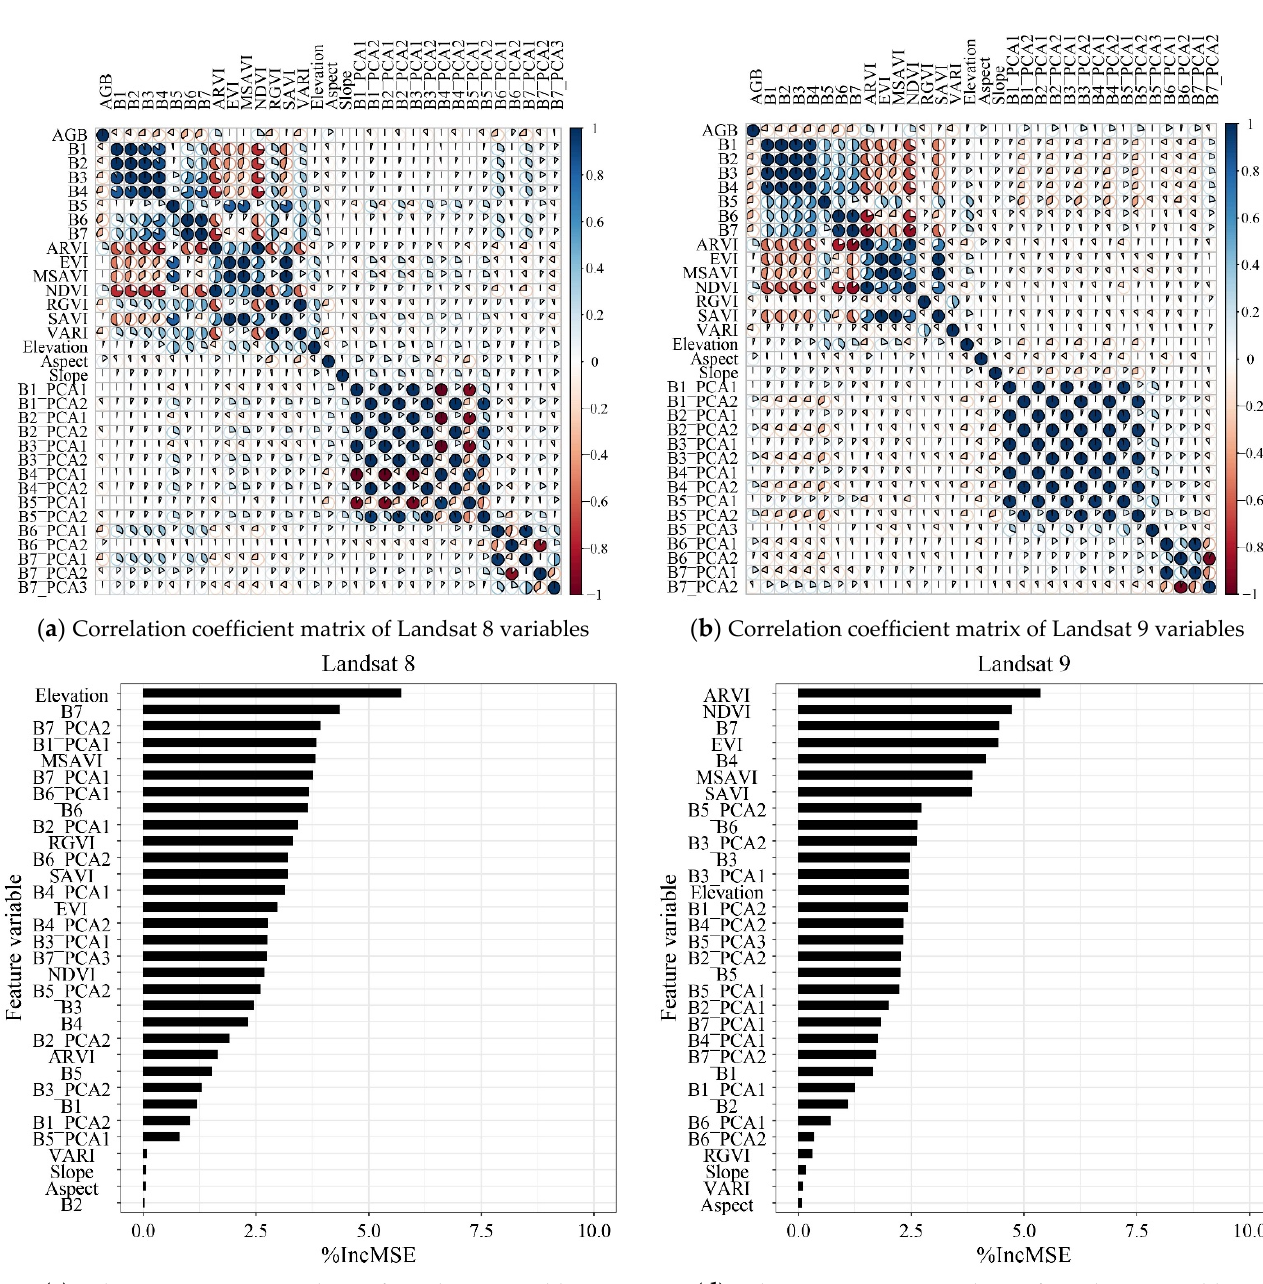
Figure 3. Correlation coefficient matrix of ( a ) Landsat 8 variables and ( b ) Landsat 9 variables; the relative importance ranking of ( c ) Landsat 8 variables and ( d ) Landsat 9